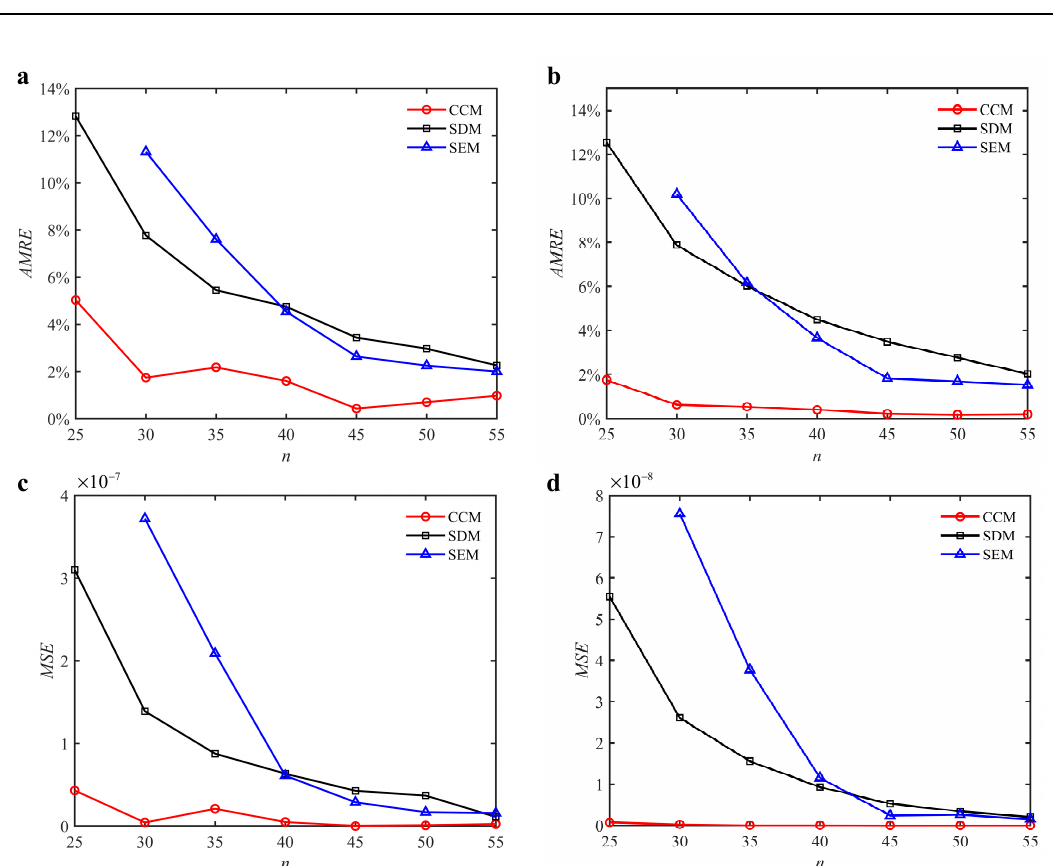
Figure 6. Computational time of the CCM, SDM, and SEM. ( a ) a / D = 0.05; ( b ) a / D = 0.5.